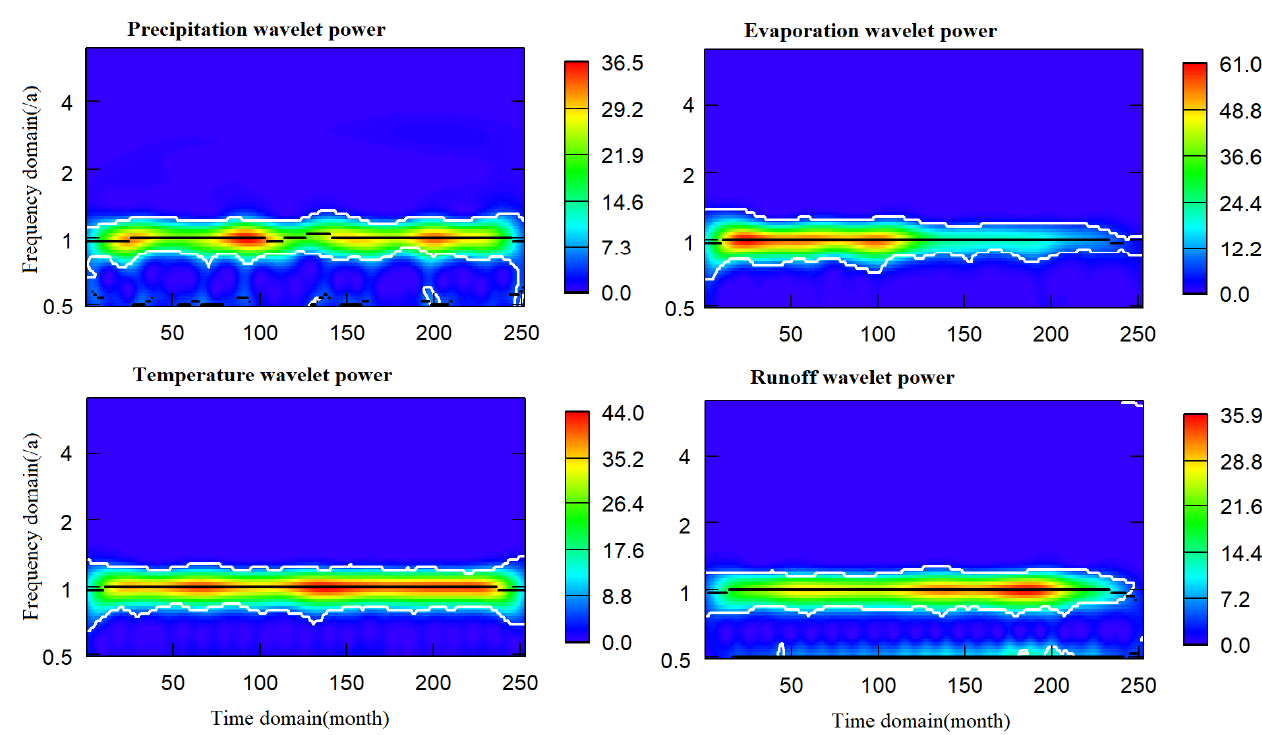
Figure 2. Wavelet power diagram of meteorological parameters from 2000 to 2020.